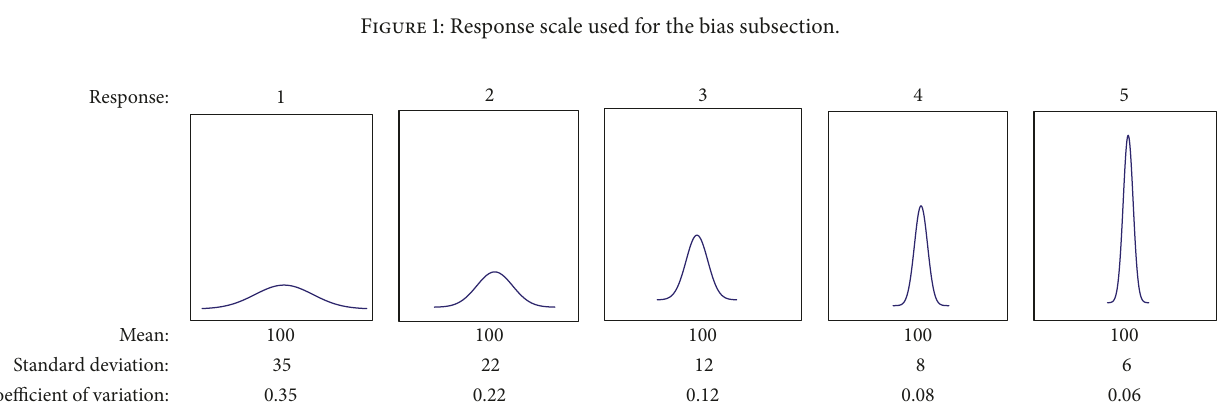
Figure 2: Representation of the scale used for the precision and reliability